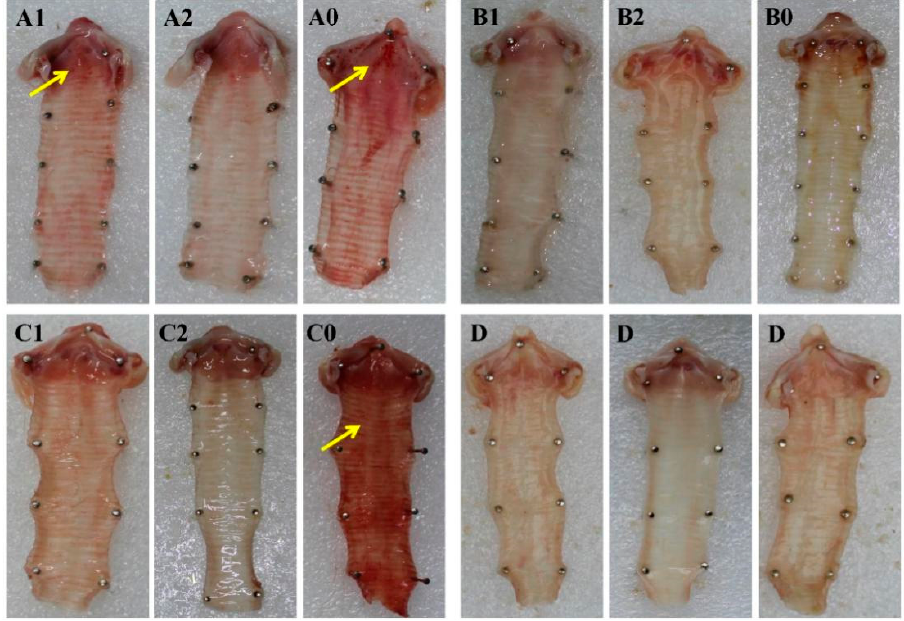
Figure 5. Gross lesions of the trachea after challenge with Av. paragallinarum . The letters in the figure correspond to the groups. Hemorrhage (yellow arrows) was observed in the trachea of chickens in groups A1, A0, and